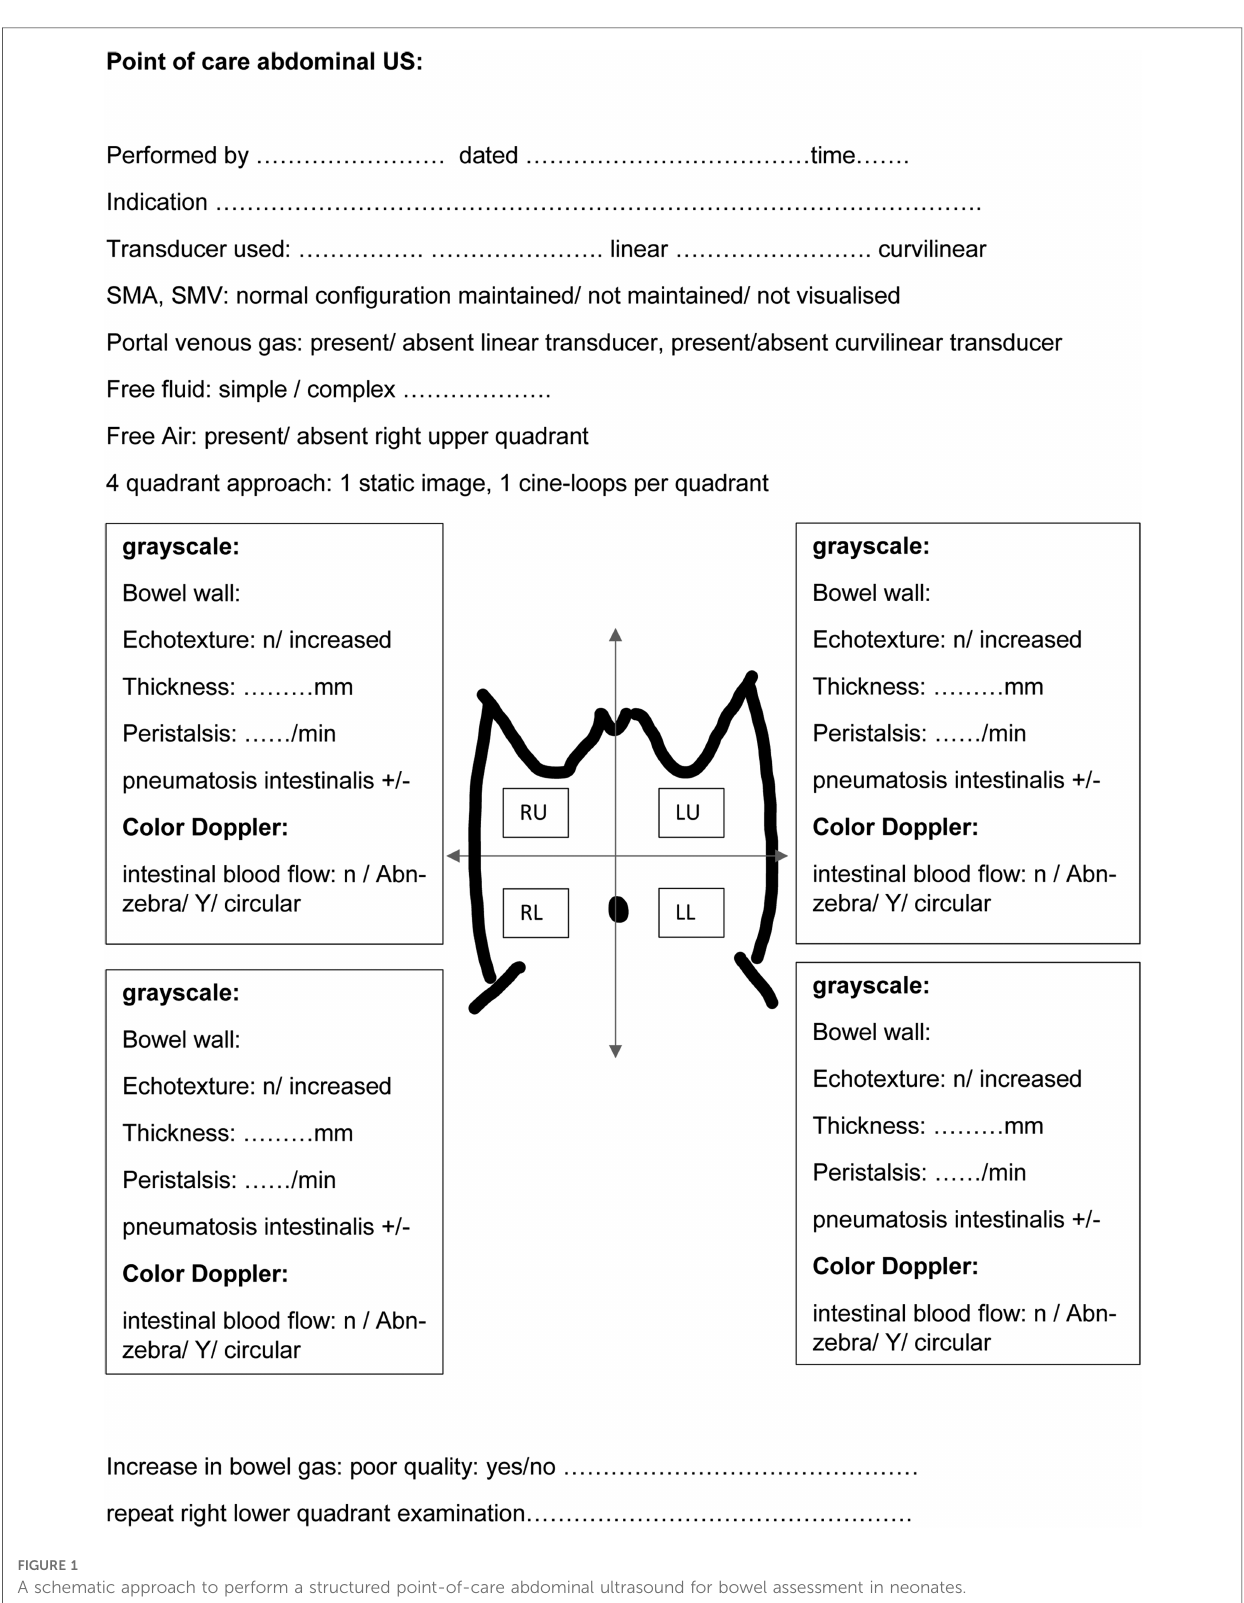
FIGURE 1 A schematic approach to perform a structured point-of-care abdominal ultrasound for bowel assessment in